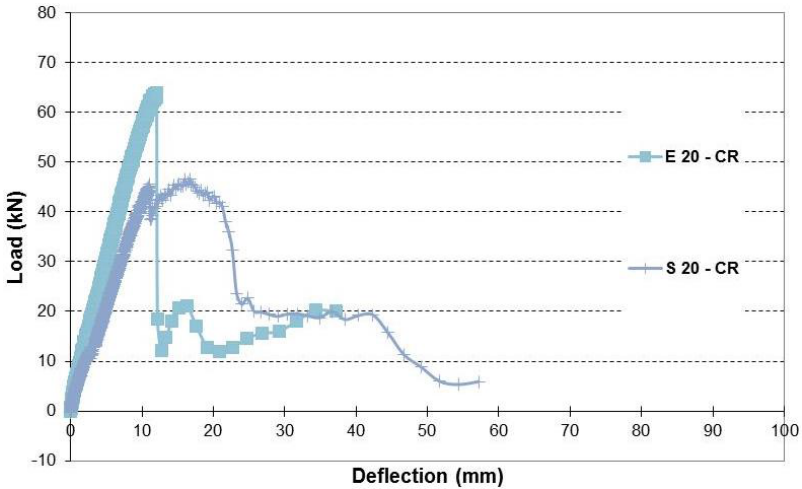
Figure 19. Load-deflection of beams with 20% corrosion levels (Repaired).